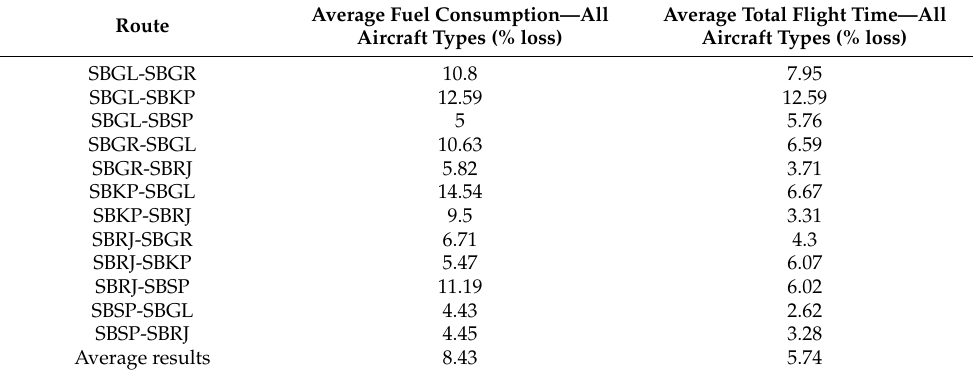
Table 1. Comparing the results of the Ideal (case1) and the Real (Case 2).